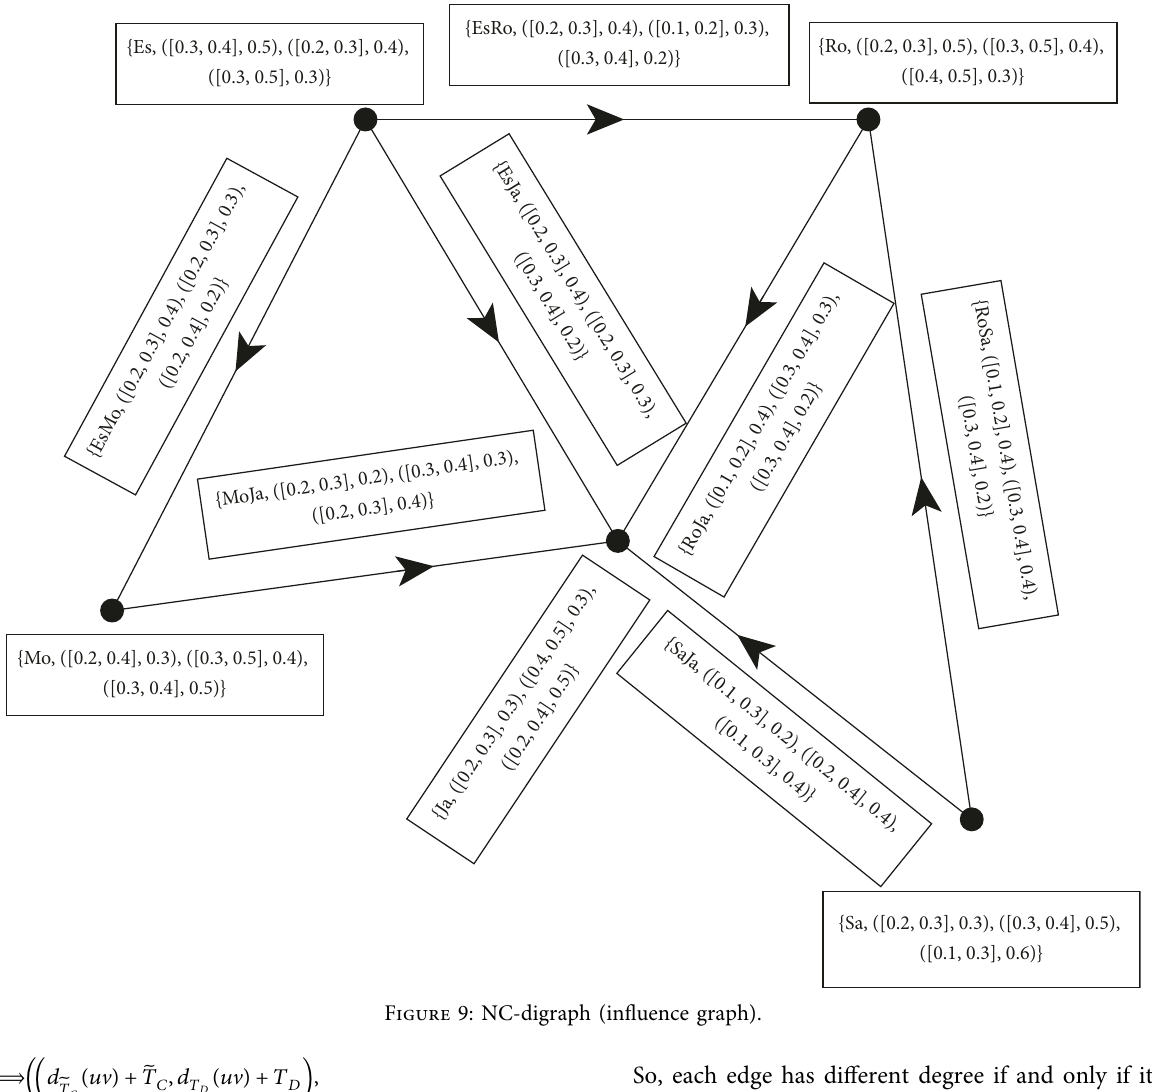
Figure 9: NC-digraph (influence